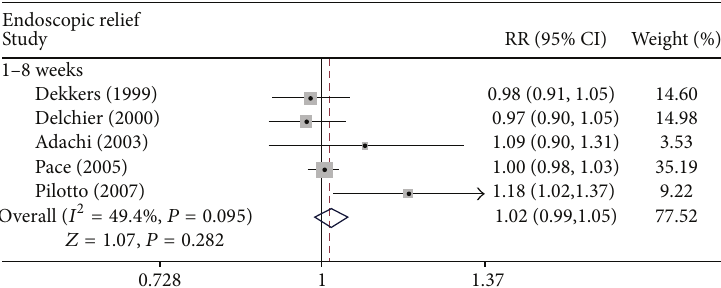
Figure 2: Effect of rabeprazole 20mg once daily versus omeprazole 20 mg once daily on endoscopic relief of GERD. RR, relative risk; CI, confidence interval.